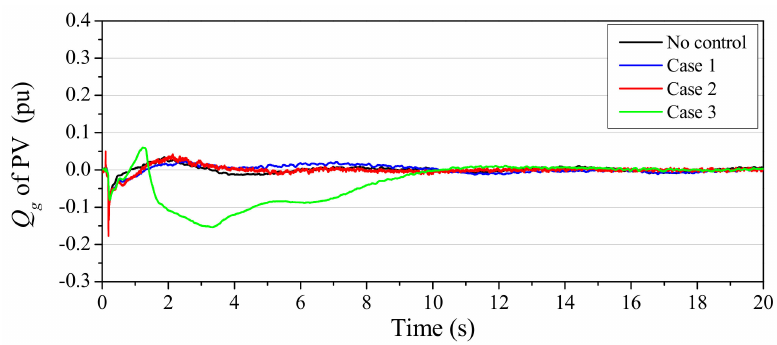
Figure 25. Active power of PV (with PV system installed).